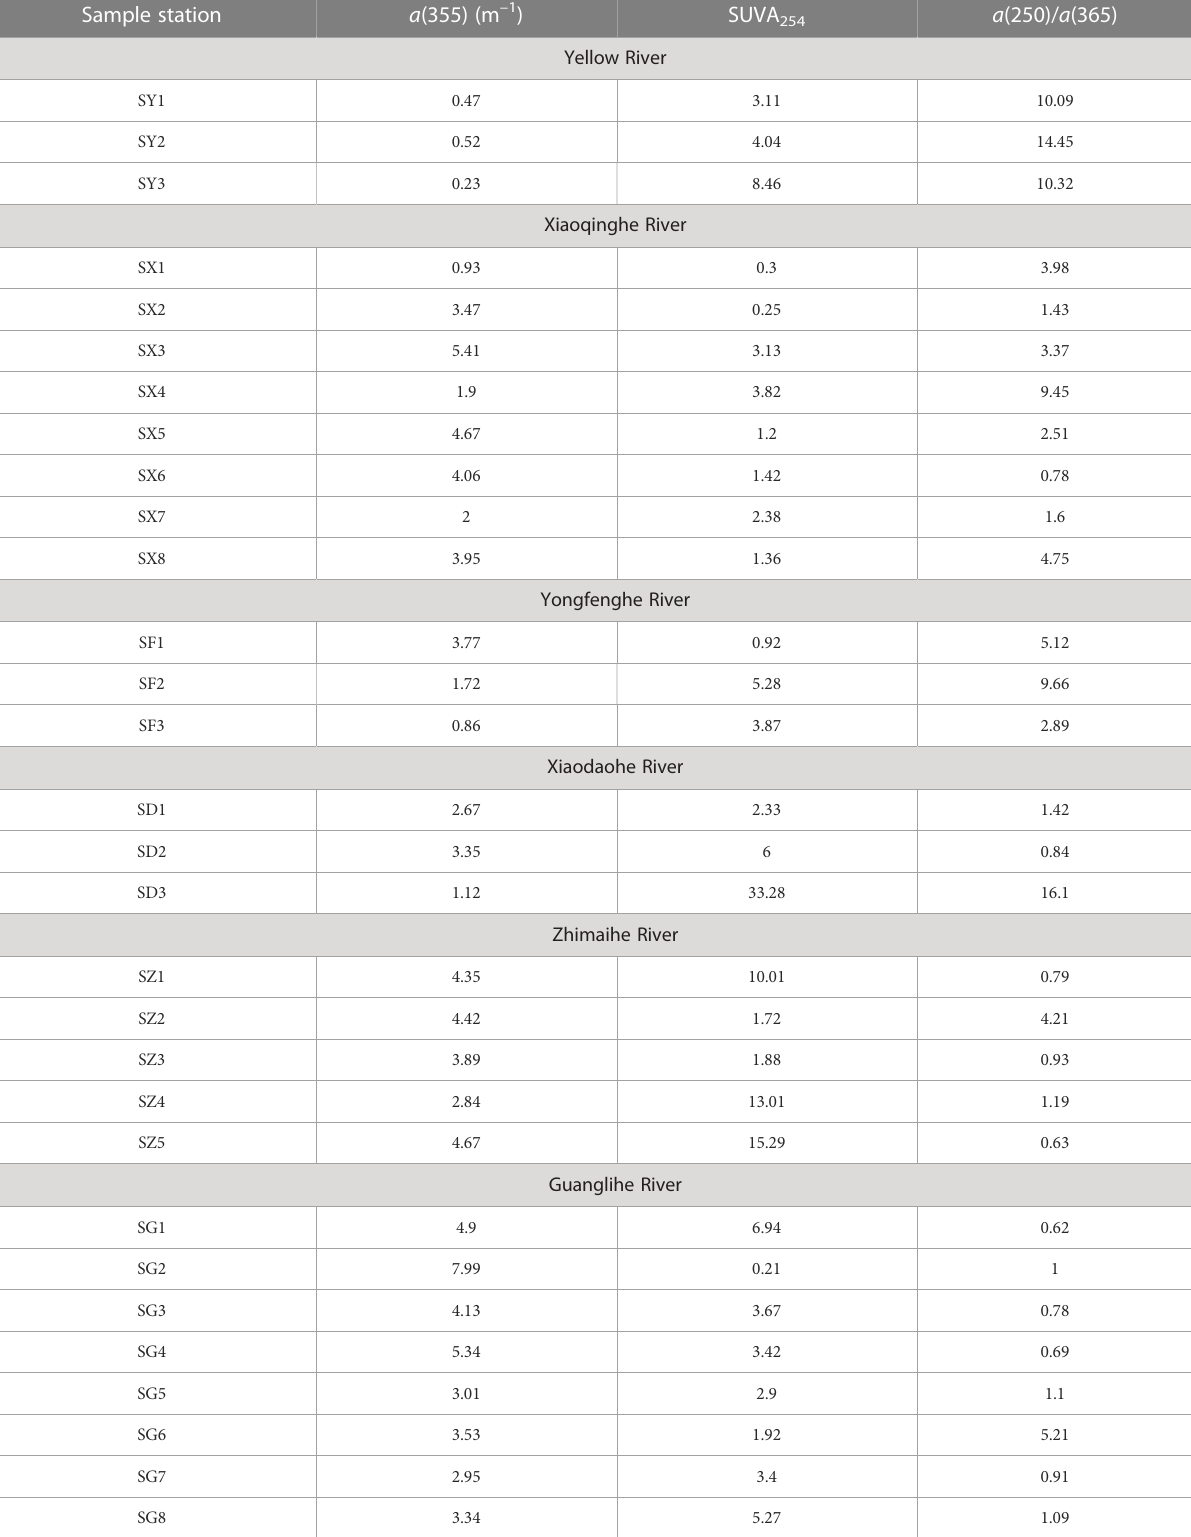
TABLE 3 The chromophoric dissolved organic matter (CDOM)-UV parameter in different sample